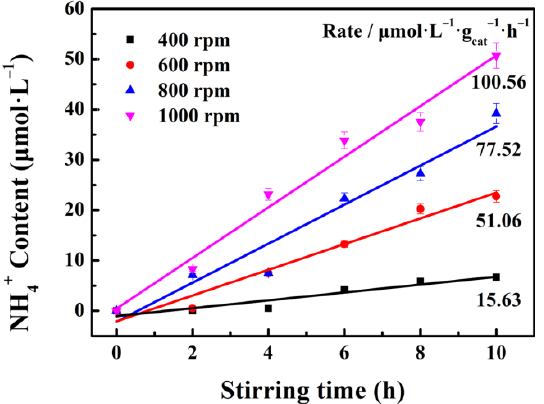
Figure 7. Tribocatalytic N 2 fixation performance of g-C 3 N 4 under the different stirring speed.